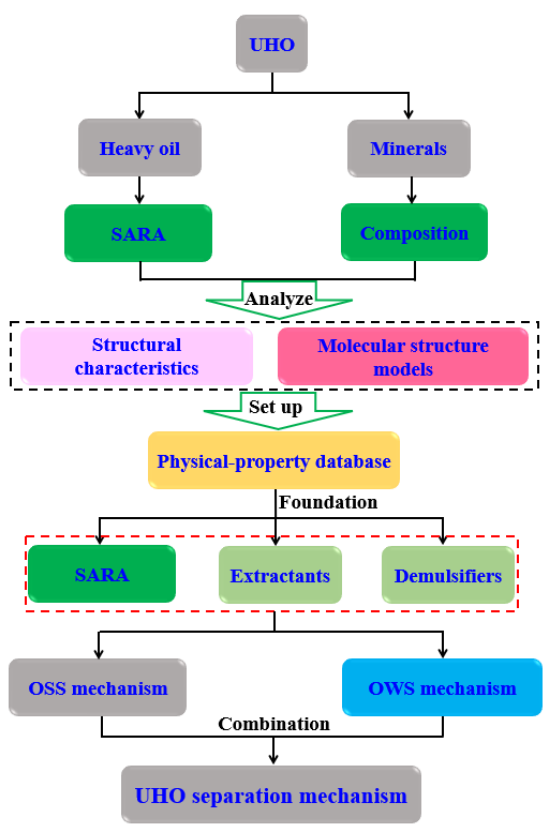
Figure 30. Schematic diagram of UHO separation mechanism construction.